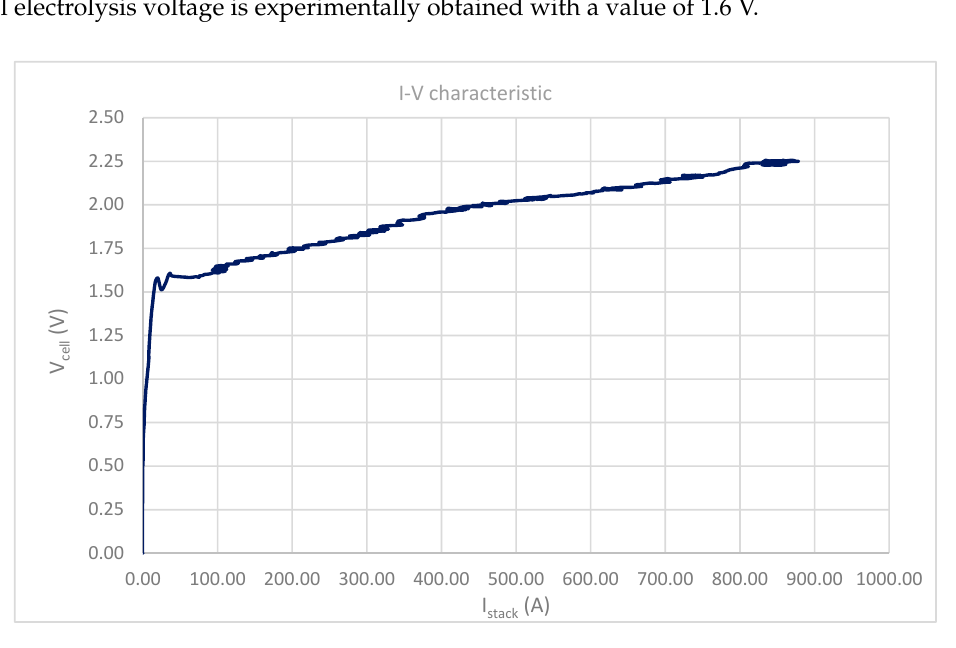
Figure 16. Experimental results. I-V characteristic of the PEM cell.